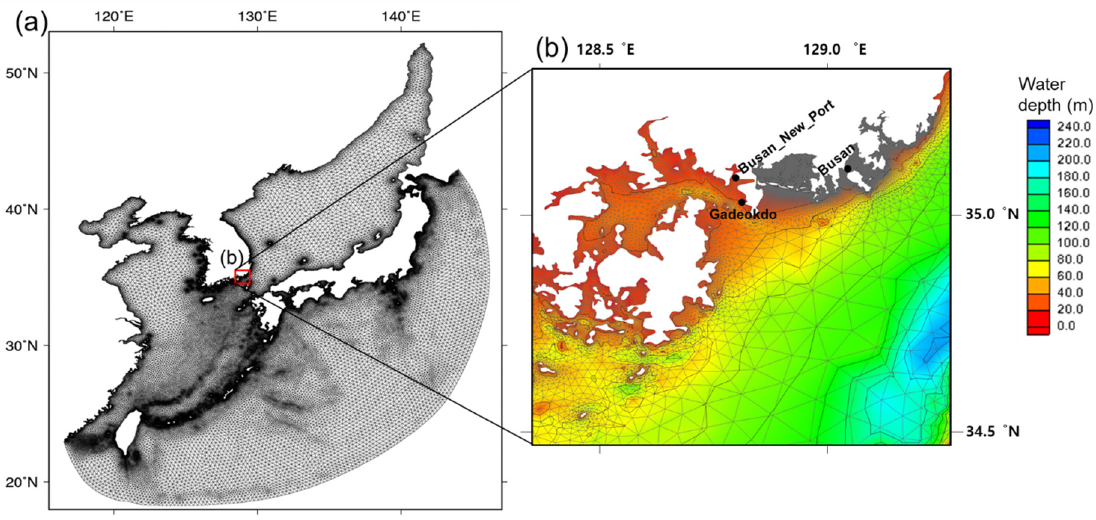
Figure 2. ADCIRC+SWAN grids: ( a ) model domain area and grids; ( b ) tide observation stations marked with black circles.